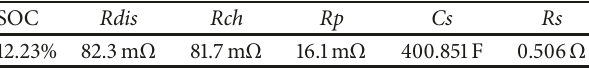
Table 1: Parameter Identification Results at 𝑈 ∗ = 3V.